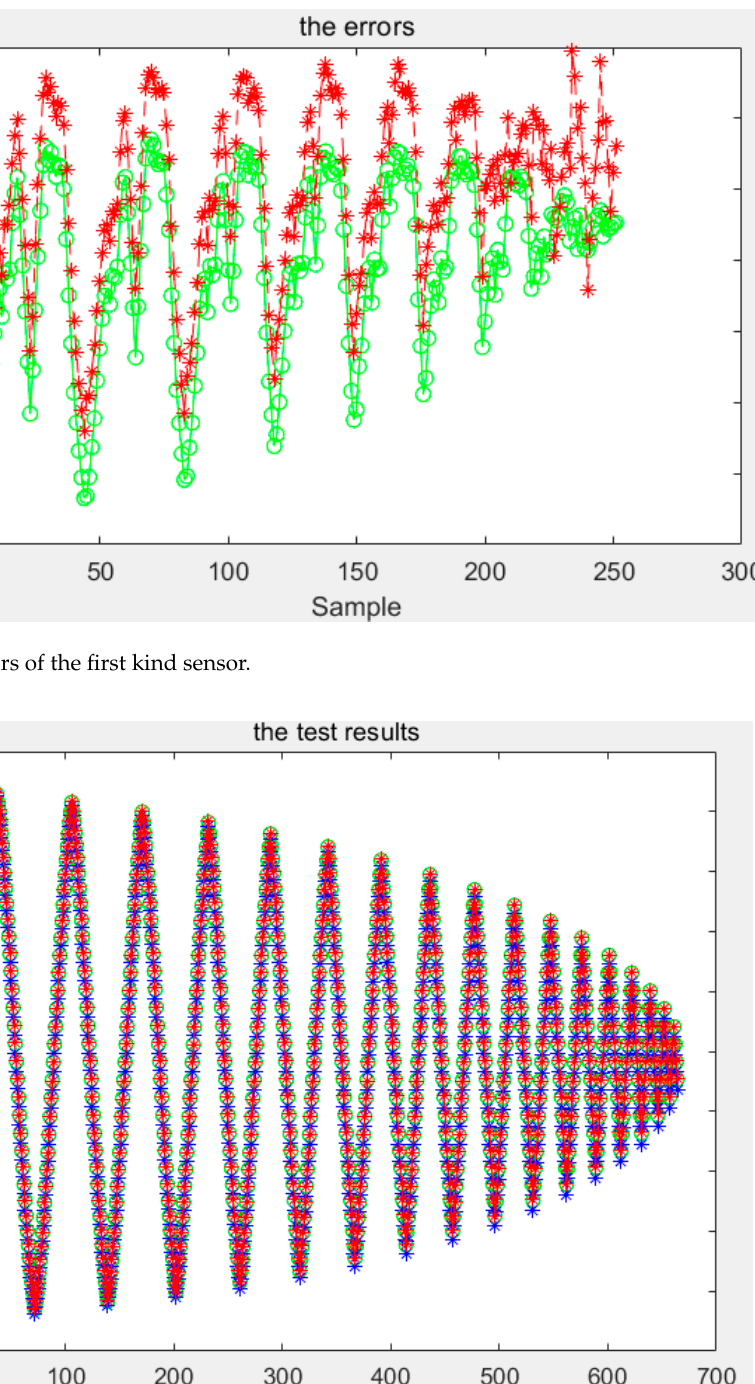
Figure 14. Test results of the second kind sensor.